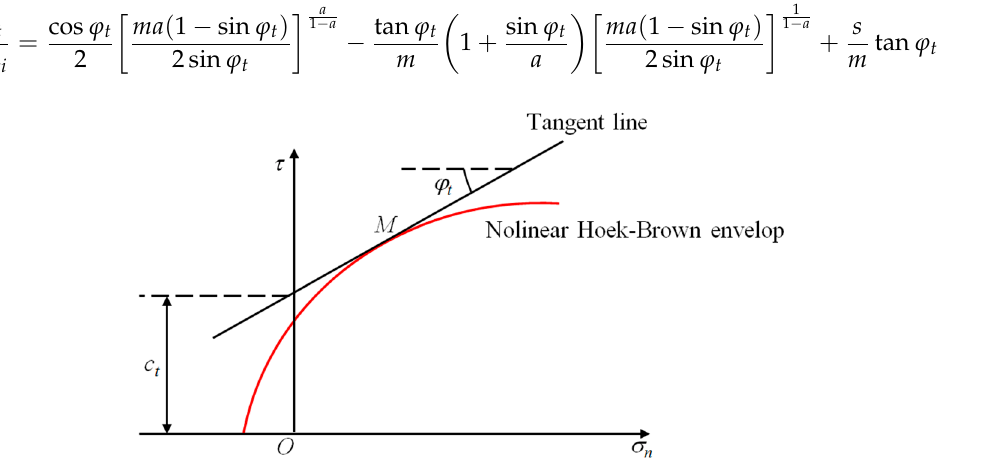
Figure 1. Generalized nonlinear Hoek–Brown failure criterion and tangent technique.